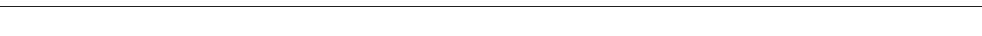
Fig. 1 Simultaneous visualization of intact mOBs and mOCs in living bones. a Schematic representation of mouse skull bone. Each small boxed region represents a single visual fi eld and each tiling image contains 10 contiguous boxed regions. b A representative, intravital, two-photon, microscopic tiling maximum-intensity projection (MIP) image of skull bone tissues from Col2.3-ECFP/TRAP-tdTomato mice held under control conditions. Cyan, mOBs expressing Col2.3-ECFP; red, mOCs expressing TRAP-tdTomato; blue, bone tissues (second harmonic generation, SHG). Scale bar, 300 µ m. c , d Magni fi ed images from b reveal two representative modes of communication between mOBs and mOCs. Scale bar, 20 µ m. c Representative images of a colony region (the region outlined in b ). Open arrowheads represent mOBs and mOCs that are separated. d Representative images of a contact area (the region delineated by dotted lines in b ). The fi lled arrowheads indicate areas of direct mOB – mOC contact. e – g Intravital two-photon microscopy time-lapse MIP images of skull bone tissues from Col2.3-ECFP/TRAP-tdTomato mice held under control conditions. e A representative MIP image captured at 0 min. Scale bar, 100 µ m. f Magni fi ed images of a colony area (the region outlined in e ) captured at 0, 120, 240, 360, and 480 min. Scale bar, 20 µ m. g Magni fi ed images of the contact area captured at 0, 30, 60, 90, 120, 150, and 180 min (the region delineated by dotted lines in e ). Scale bar, 15 µ m. h 3D colocalization analysis of the images shown in g . The contact area is the region of colocalization of mOBs and mOCs and is shown in yellow. Scale bar, 15 µ